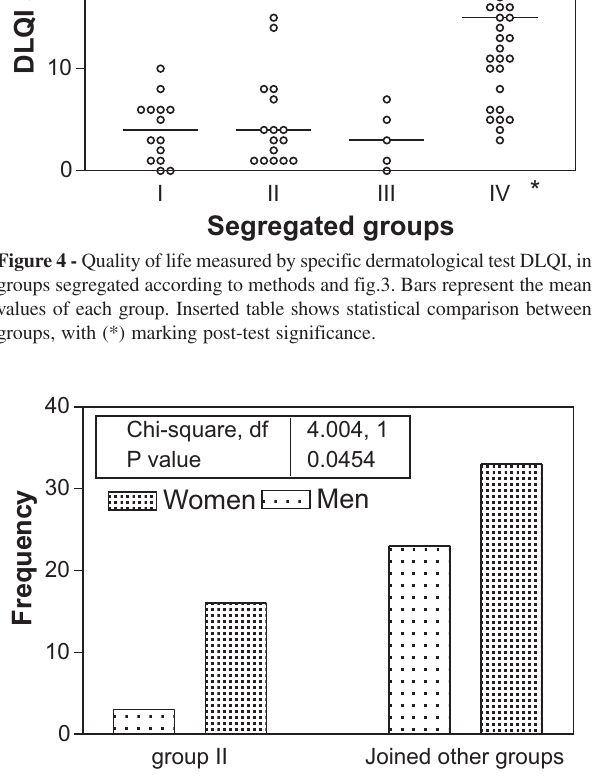
Figure 5 - Female predominance in group II when compared with joined populations of other groups. Table shows Chi-square values and significance.